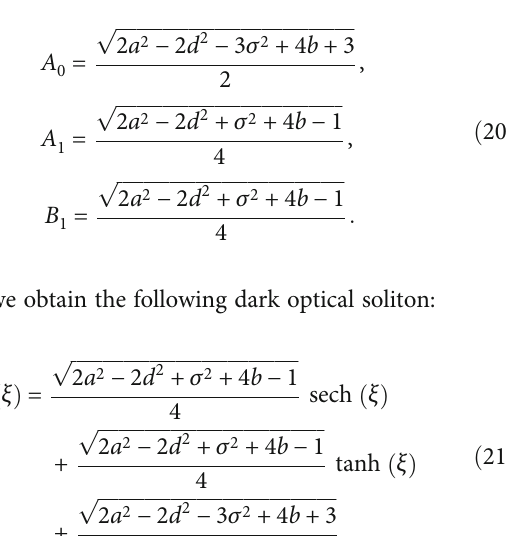
Figure 2: Dynamic behaviors of solution u